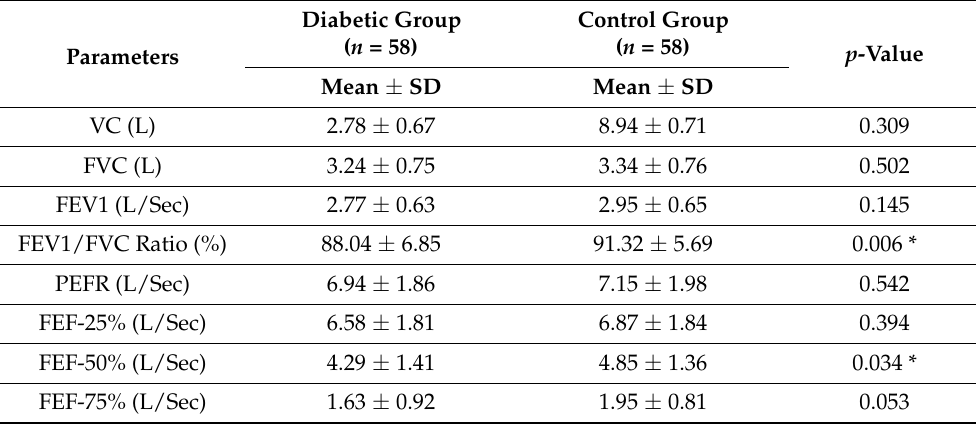
Table 5. Lung functions parameters for type 2 diabetic patients with HbA1c ≤ 8 compared with their matched